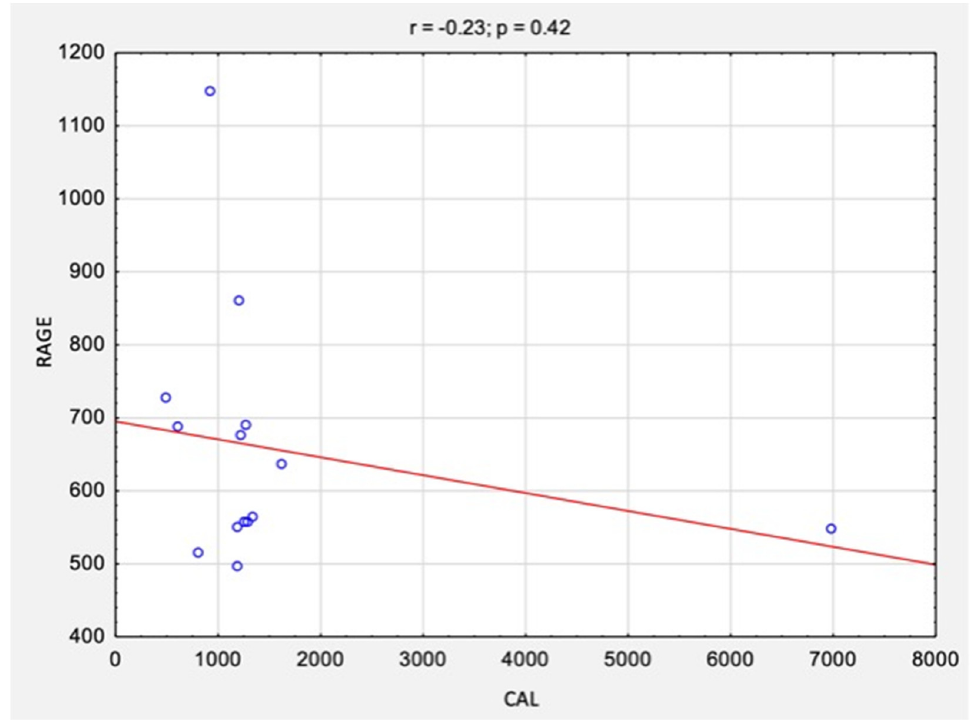
Figure 5. The correlations between the results of CAL and RAGE levels after surgical treatment. Abbreviations: r, Spearman’s correlation coefficient; n, number of participants; p, level of statistical significance; CAL, calprotectin; RAGE, receptor for advanced glycation end products.